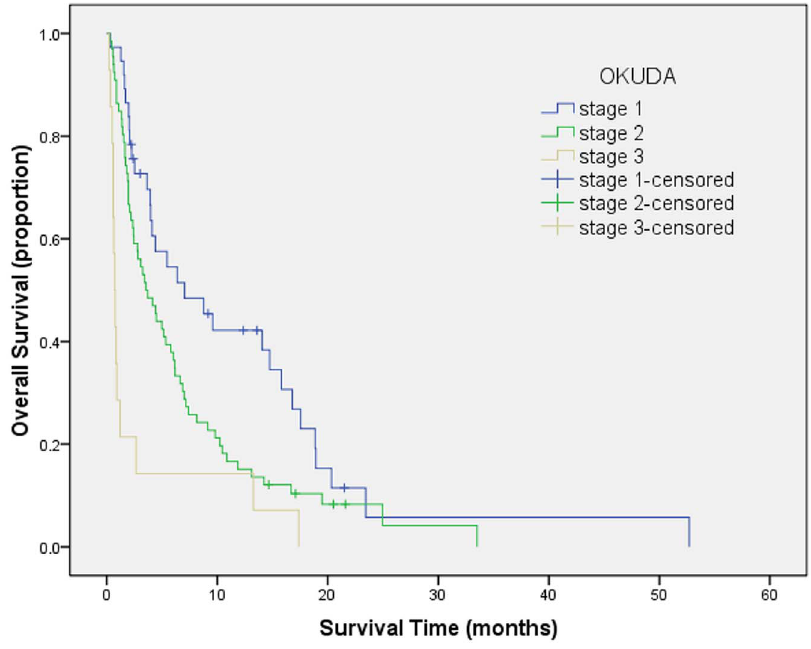
Figure 2. Survival curves for patients with unresectable hepatocellular carcinoma who stratified according to the Okuda staging system. Stage 1 versus 2, P=.015; stage 2 versus 3, P=.010. Statistical difference was noted between any stages.